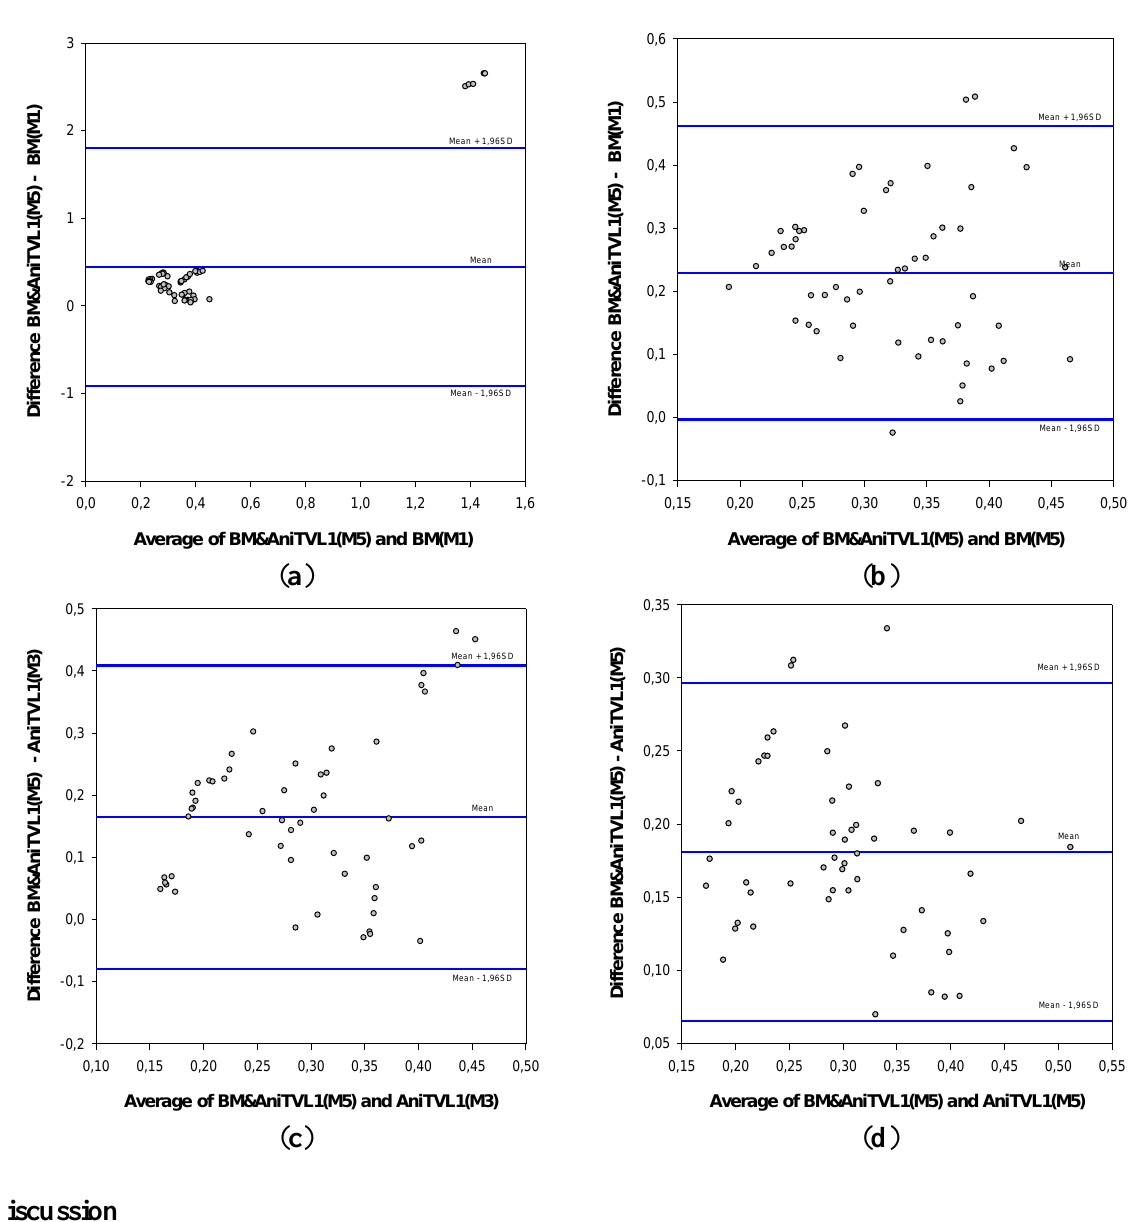
Figure 10. Bland-Altman figure, where the best obtained results block matching & anisotropic TV-L1 (M5) are compared with ( a ) block matching (M1), ( b ) block matching (M5), ( c ) anisotropic TV-L1 (M3), and ( d ) anisotropic TV-L1